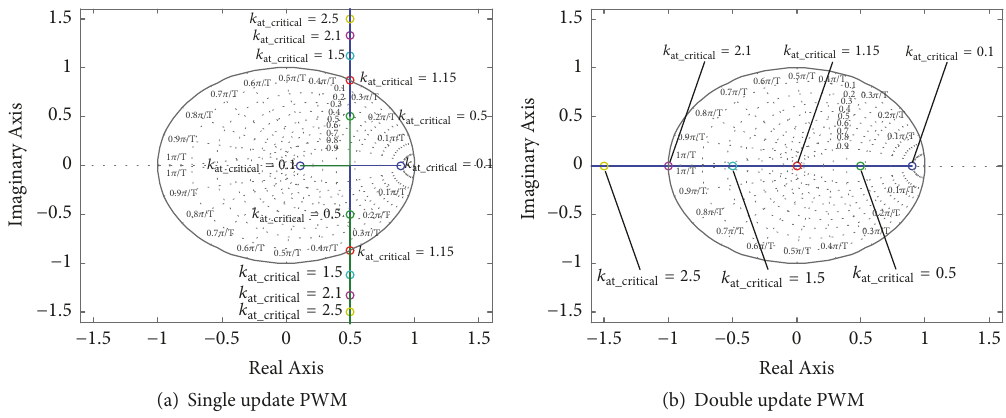
Figure 7: The contrast analysis of root locus with different 𝑘